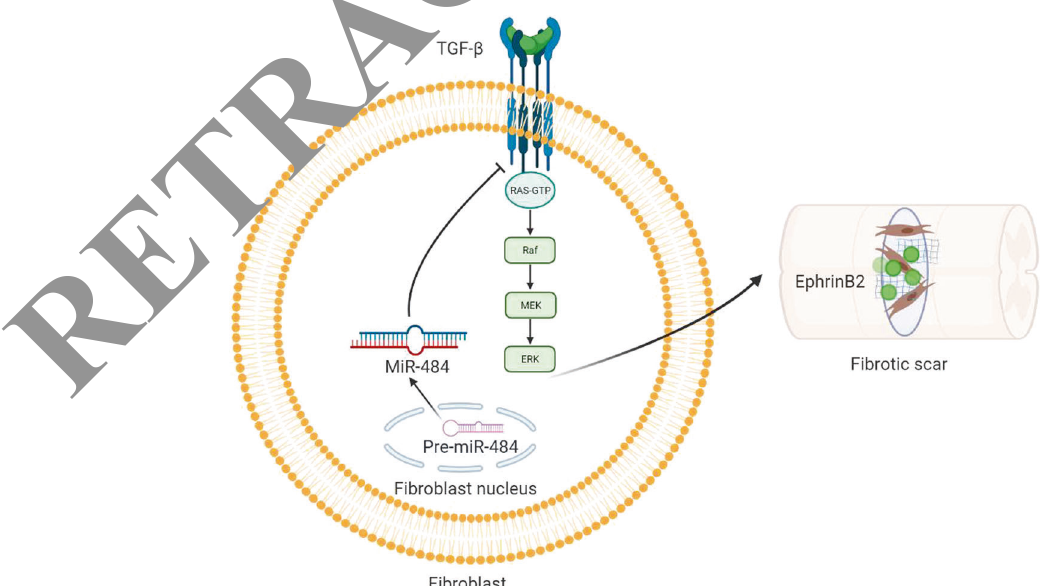
Fig. 8 Schematic review of the whole study. TGF- β mediates EphrinB2 expression, fi broblasts distribution, and fi brotic scar formation in the lesion area by activating miR-484 in fi broblasts.